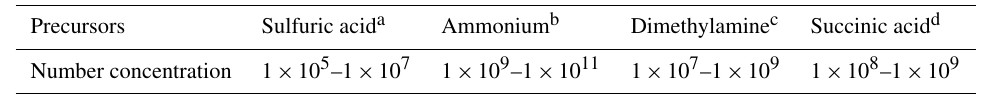
Table 3. Typical ranges of gas-phase concentrations (molecules cm − 3 ) for sulfuric acid, ammonium, dimethylamine, and succinic acid in the atmosphere.